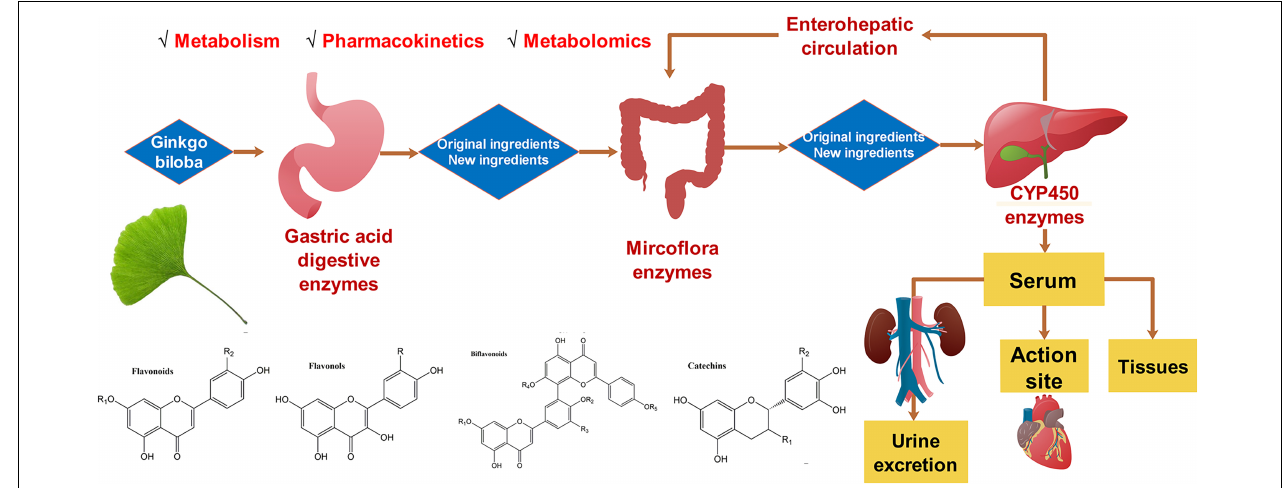
FIGURE 1 | The metabolism, pharmacokinetics, and metabolomics of Ginkgo biloba flavonoids.